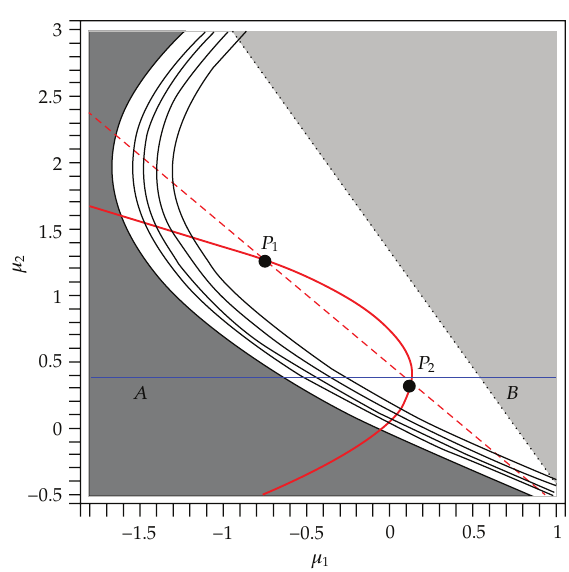
(cid:4) μ (cid:5) (cid:9) 0 and p μ (cid:4) − 1 (cid:5) (cid:9) 0, 0 3 0